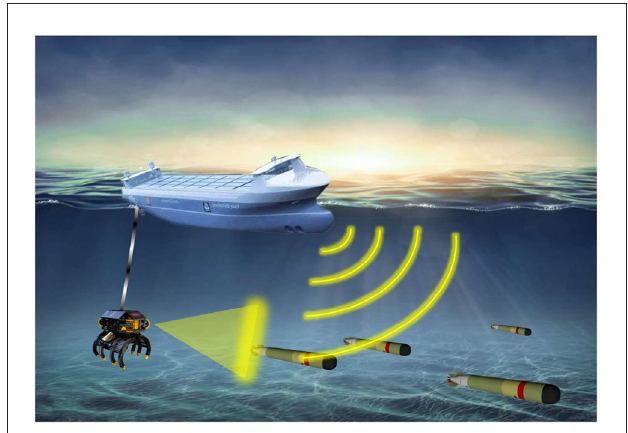
FIGURE1 A schematic diagram of a claw underwater salvage